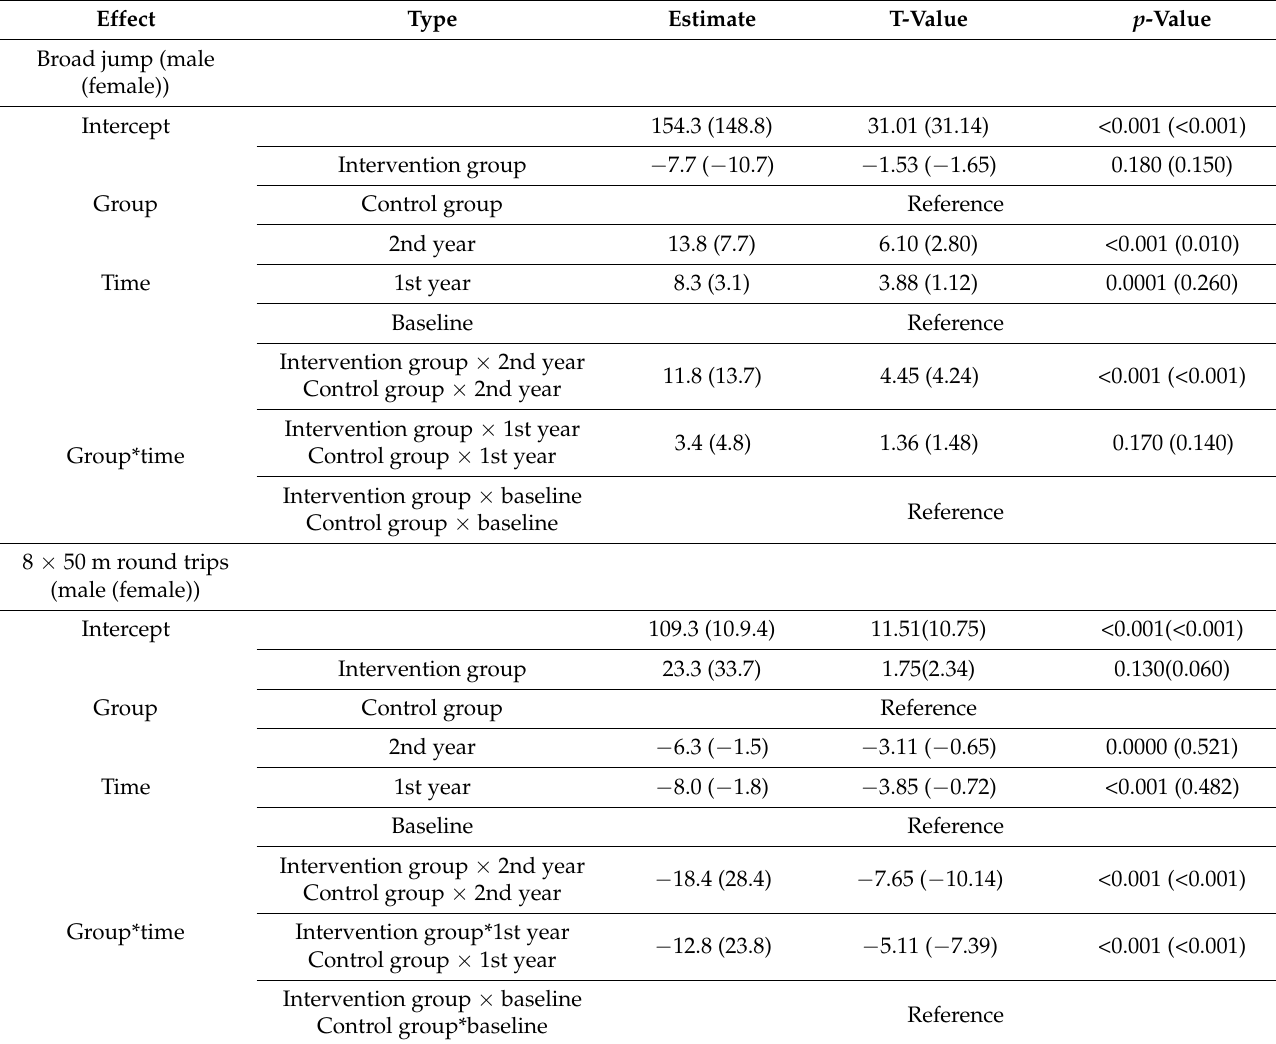
Table A2. Test hypothesis results of fixed effects of broad jump and 8 × 50 m round trips.